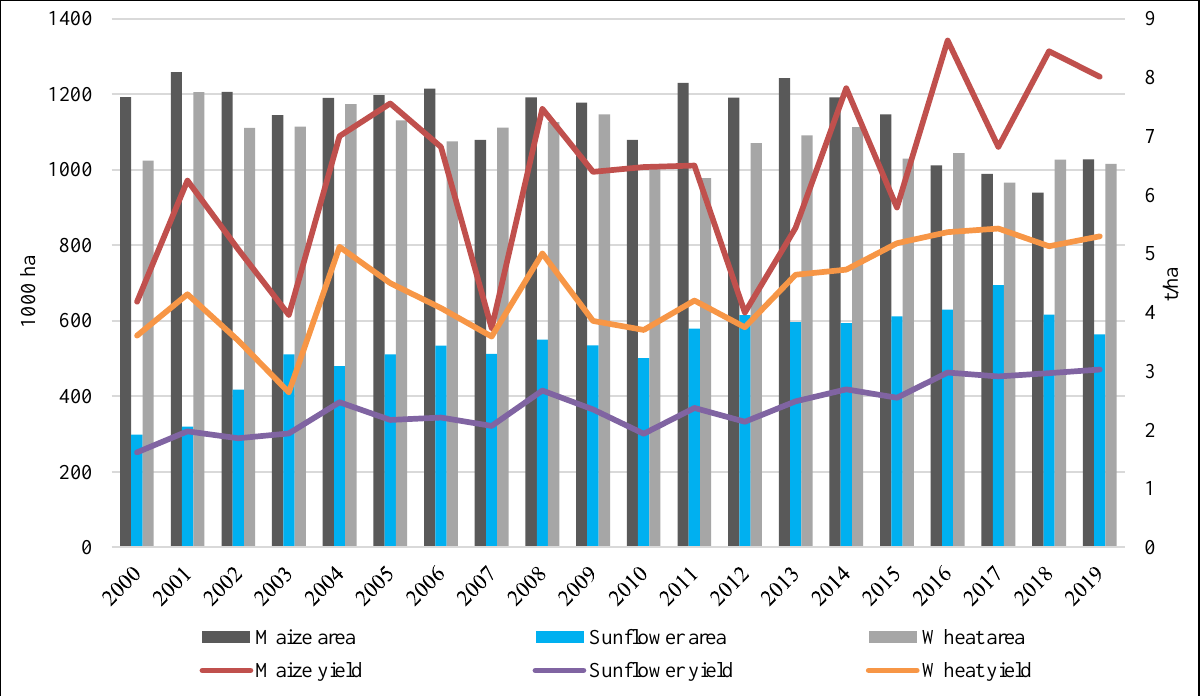
Figure 3. Area and yield of the three major crop products; Source: Author’s composition based on FAO [23] Maize has the highest production area, which was above 1 million hectares in most of the analyzed years. This crop also has the highest yield. The unfavorable weather conditions, e.g. the late snow in April and summer heat waves of 2003, drought and heat waves in 2007, and the very hot and extremely dry August of 2013, caused sharp declines in yields. Wheat and, especially, sunflower yields were lower than that of maize, even as they showed more resistance towards the extreme weather conditions. Using better production technologies and irrigating more would be the best practices for producing at higher and more stable rates.